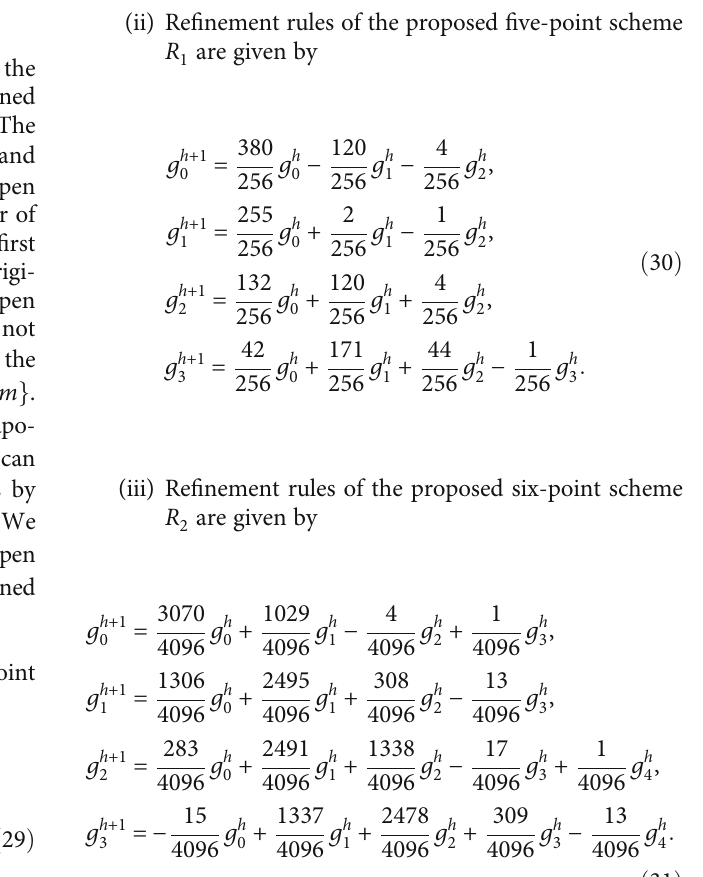
Figure 2: Behavior of the proposed R three